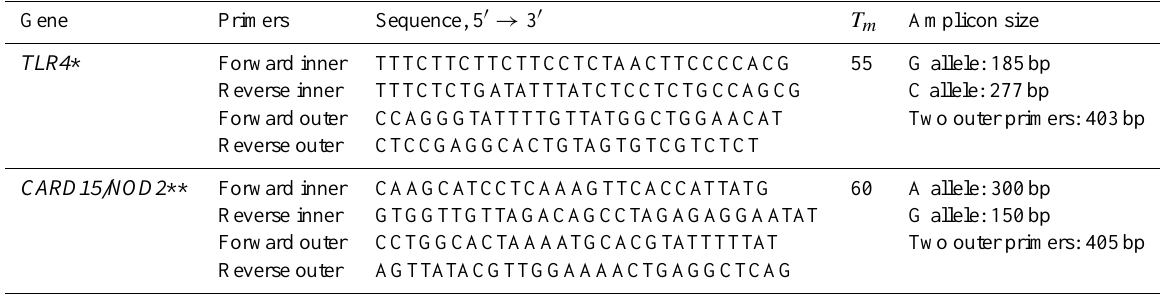
Table 1. Primers and conditions applied to identify selected SNPs of TLR4 and CARD15/NOD2 . Gene Primers Sequence, 5 (cid:48) → 3 (cid:48) T m Amplicon size TLR4 * Forward inner TTTCTTCTTCTTCCTCTAACTTCCCCACG 55 G allele: 185bp Reverse inner TTTCTCTGATATTTATCTCCTCTGCCAGCG C allele: 277bp Forward outer CCAGGGTATTTTGTTATGGCTGGAACAT Two outer primers: 403bp Reverse outer CTCCGAGGCACTGTAGTGTCGTCTCT CARD15/NOD2 ** Forward inner CAAGCATCCTCAAAGTTCACCATTATG 60 A allele: 300bp Reverse inner G allele: 150bp Forward outer CCTGGCACTAAAATGCACGTATTTTTAT Two outer primers: 405bp Reverse outer